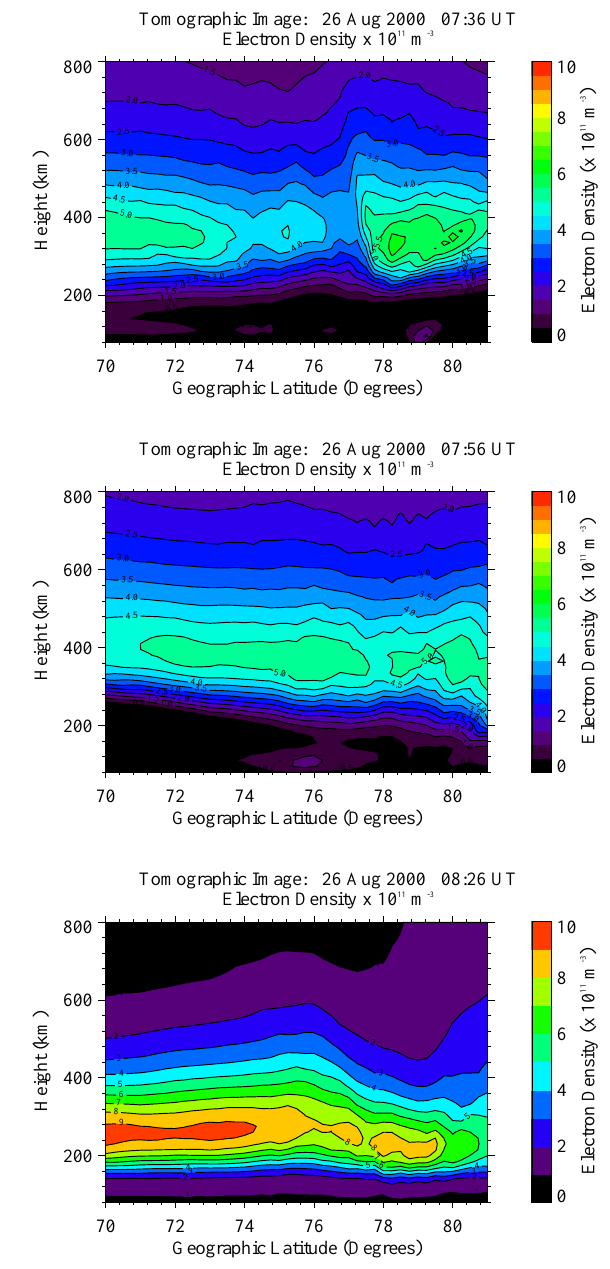
Fig. 5. Tomographic images of the spatial distribution of electron density during three satellite passes crossing a latitude of 75.0 ◦ N at 07:36 UT (upper panel), 07:56 UT (centre panel) and 08:26 UT (lower panel) plotted as a function of height and geographic